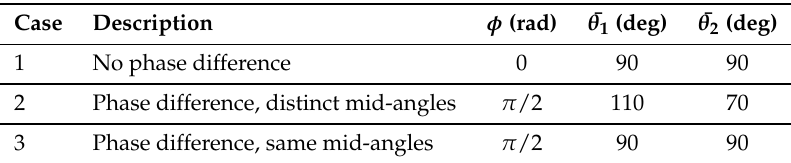
Table 1. Parameters varied in the three experimental cases: phase difference φ and the median orientation angles ¯ θ 1 and ¯ θ 2 of the two arms.